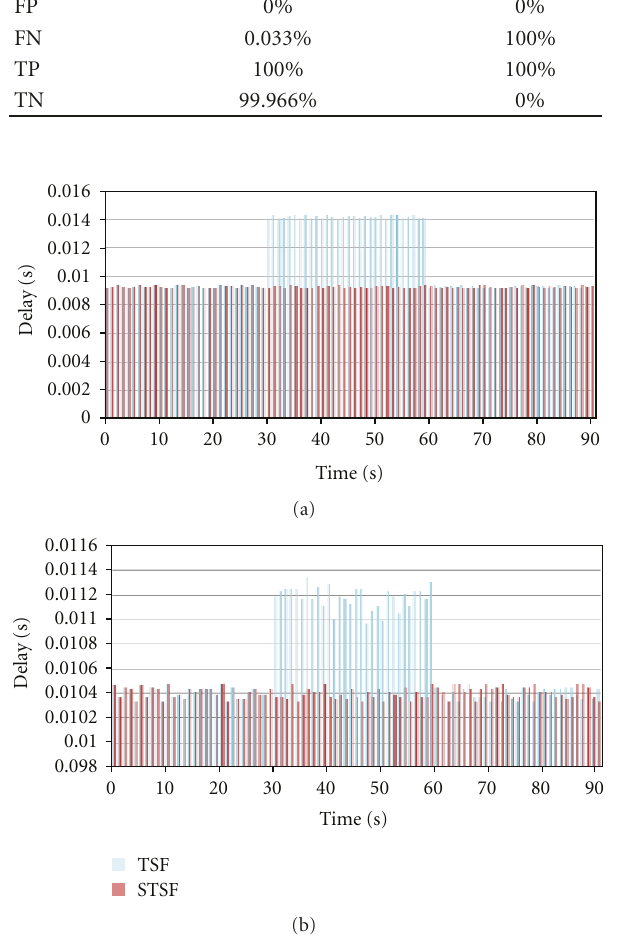
Figure 12: Impact of synchronization attack on delay: (a) for the disabled handshake and (b) for the enabled handshake.